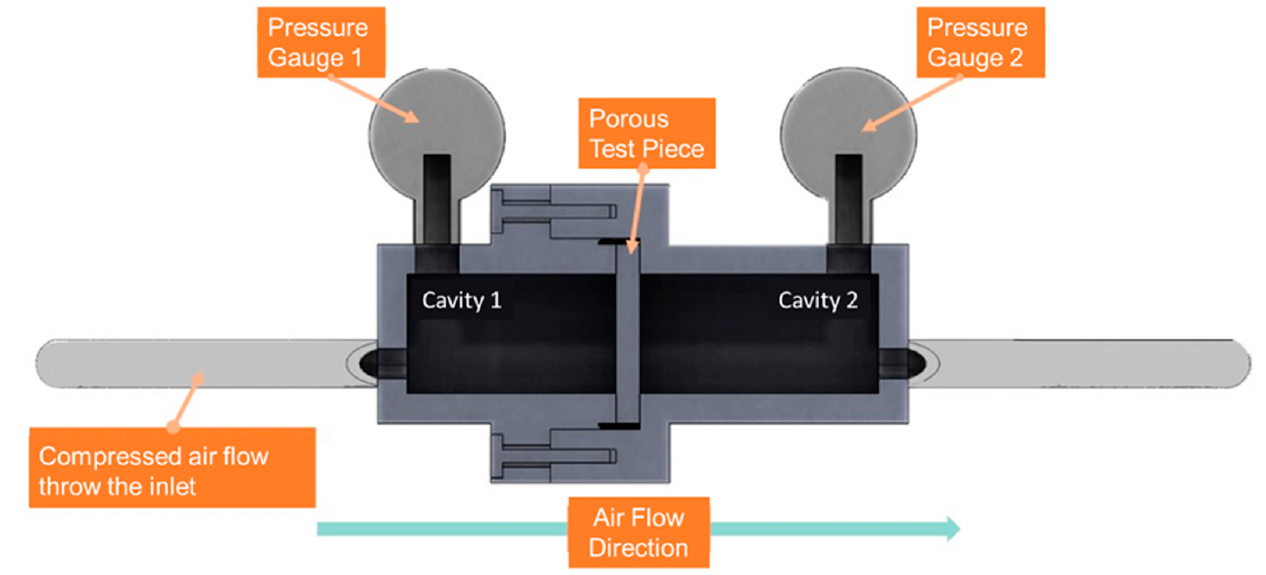
Figure 2. Schematics of the apparatus for air flow across cellular test coupons.